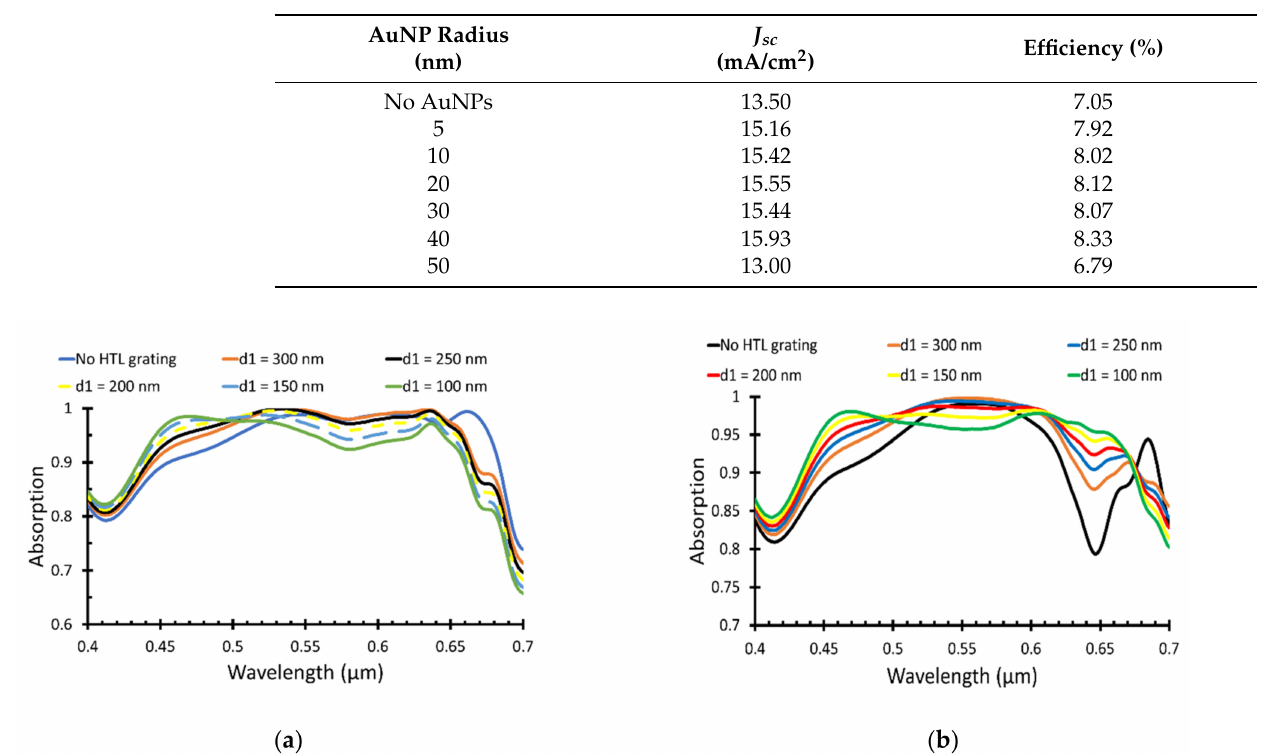
Table 2. J sc and PCE for different AuNP radii.